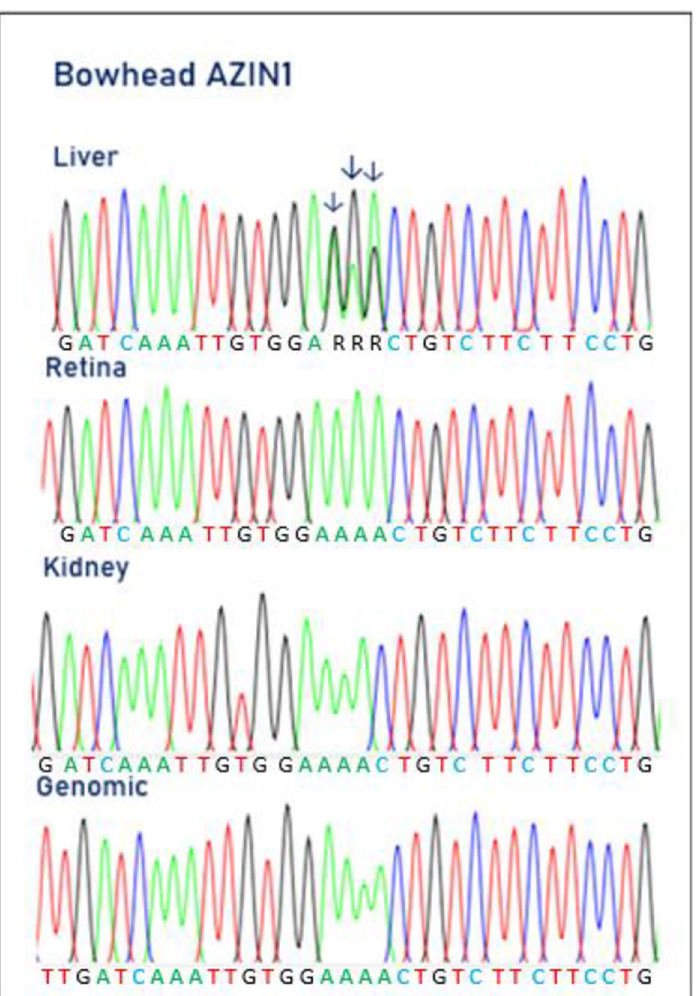
Fig 3. Electropherograms showing AZIN1 pre-mRNA editing in bowhead liver, retina and kidney. Electropherograms showing editing in liver (upper panel), retina (middle panel) and kidney (lower panel). The three adenosines subject to editing, within codon number 367, are indicated by